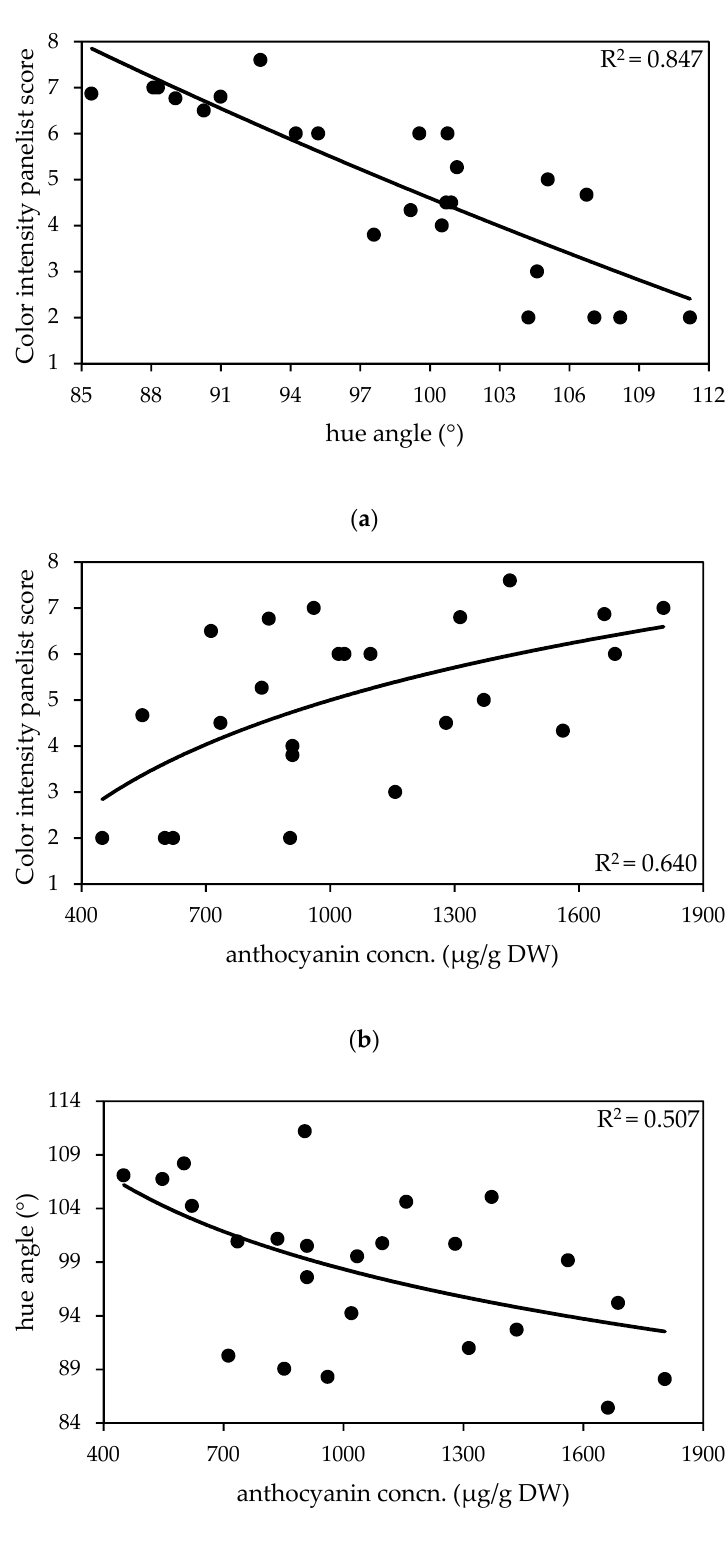
Figure 2. Relationship between: ( a ) Hue angle measured with a colorimeter and panelist color intensity scores (0–15 scale) given by panelists; ( b ) Anthocyanin concentration measured with a spectrophotometer and color intensity scores; and ( c ) Anthocyanin concentration and hue angle for lettuce grown under 6 different high tunnel coverings in Olathe, KS in fall 2017.